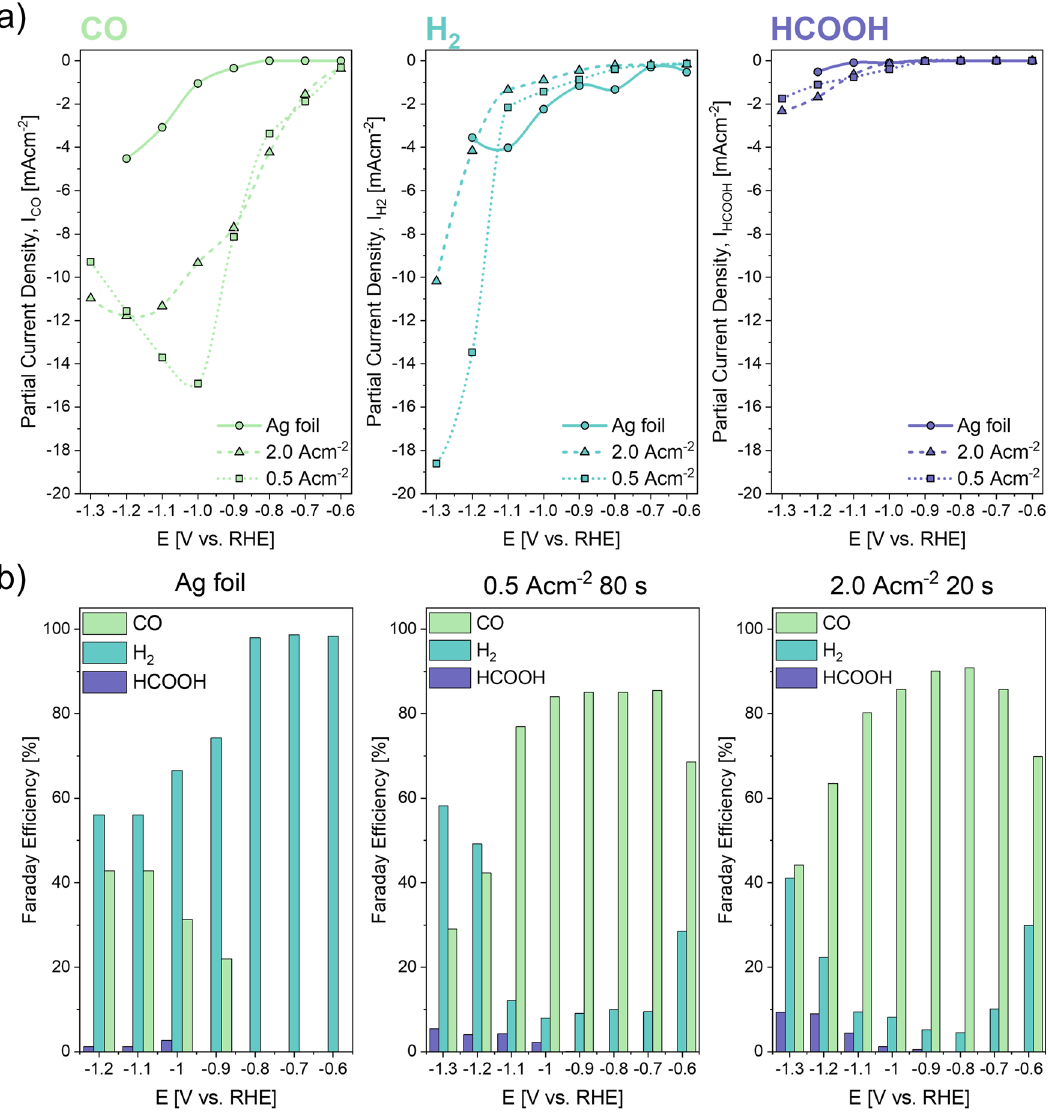
Fig. 1 Electrochemical performance in CO 2 RR of the pristine and polished Ag foil compared to Ag foam electrodes (deposited at 2.0 Acm − 2 20 s and 0.5 Acm − 2 80 s). a Partial current densities and b faradaic ef fi ciencies of the main evaluated